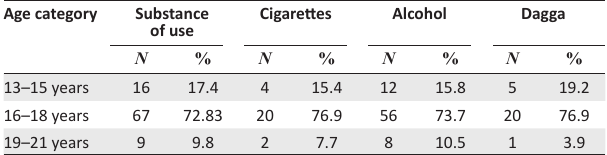
TABLE 4: Substance use according to age ( n = 94).